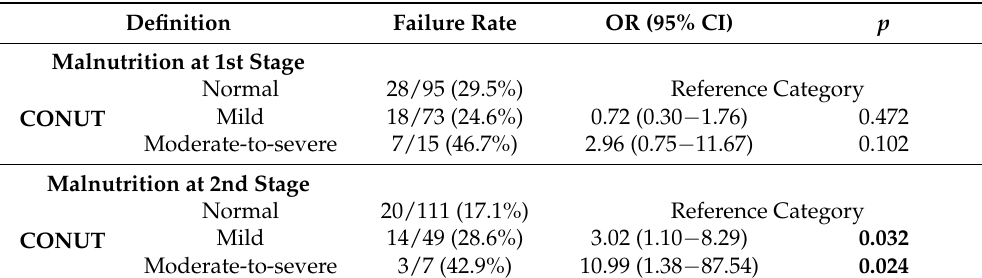
Table A2. Association between total treatment failure and malnutrition identified by Controlling Nutritional Status